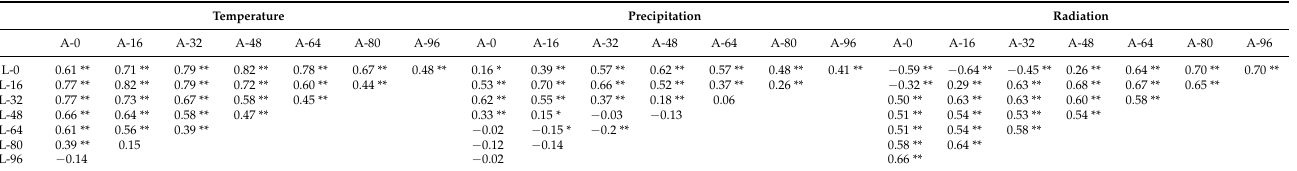
Time effects were examined by analyzing the PCC between the NDVI and climate variables over different periods (Table 1). The NDVI time series had the strongest PCC with temperature and precipitation at L-16/A-16 (cumulative over 16 days with 16 days of lag), and the maximum PCC values were 0.82 and 0.70, respectively. The response of the NDVI to radiation showed no time lag but a strong time accumulation effect (L-0/A-96, accumulated over 96 days with no day lag), and the maximum PCC was 0.70. Table 1. Partial correlation coefficients between the NDVI and climatic factors when considering the time effect. Temperature Precipitation